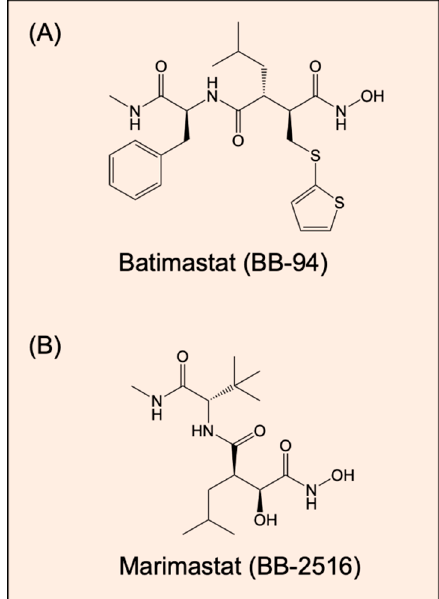
Figure 2. Line drawings of the structures of: ( A ) batimastat (BB-94) and ( B ) marimastat (BB-2516).